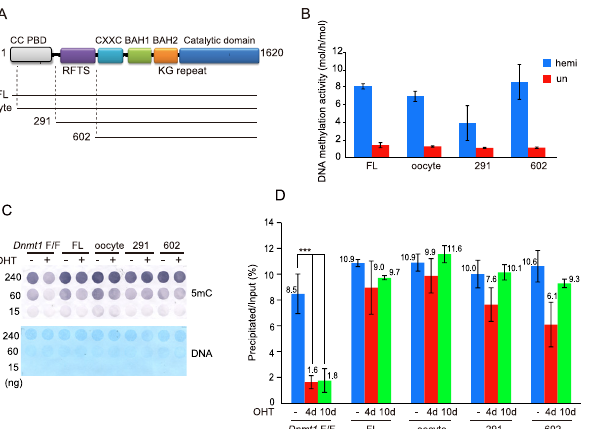
Fig 1. Global DNA methylation in ESC expressing ectopic Dnmt1. ( A ) Schematic illustration of the Dnmt1 structure. Dnmt1 is composed of an N-terminal independently folded domain (NTD) comprising a coiled-coil (CC) and the PBD, the RFTS domain, the CXXC motif, two BAH domains (BAH1 and BAH2), a KG repeat (KG), and a catalytic domain for cytosine methyltransferases. Below the illustration the constructs used in the present study are indicated. ( B ) The DNA methylation activities of full-length Dnmt1 (FL), oocyte-type Dnmt1 (oocyte), Dnmt1(291 – 1620) (291), and Dnmt1(602 – 1620) (602). The specific activities (mol/h/mol Dnmt1) towards hemi-methylated (blue, hm) and un-methylated (red, um) DNA are shown as averages ± S. D. (n = 3). ( C ) Genome DNA prepared from ESC expressing no ectopic Dnmt1 ( Dnmt1 -F/F), or full-length Dnmt1 (FL), oocyte-type Dnmt1 (oocyte), Dnmt1(291 – 1620) (291), or Dnmt1(602 – 1620) (602) treated without (-) or with OHT (+) for four days was immuno-detected with anti-methylated cytosine antibody (5mC, upper panel) or stained with methylene blue (DNA, lower panel). The amounts of DNA are shown at the left. ( D ) Genome DNA prepared from the ESC treated without (-) or with OHT for four (4d) or ten days (10d) was fragmented by sonication, and then precipitated with MBD1. The precipitated DNA was normalized as to that of input DNA. The precipitated DNA is expressed as the averages ± S. D. for more than three independently prepared genome preparations for before and after the OHT treatment, respectively. All the ESC expressing ectopic Dnmt1 showed significant methylation levels compared to that without ectopic Dnmt1 after the OHT treatment (p < 0.001) except for the ESC expressing Dnmt1(602 – 1620), which was p < 0.01. ** , p < 0.01, and *** p < 0.001.